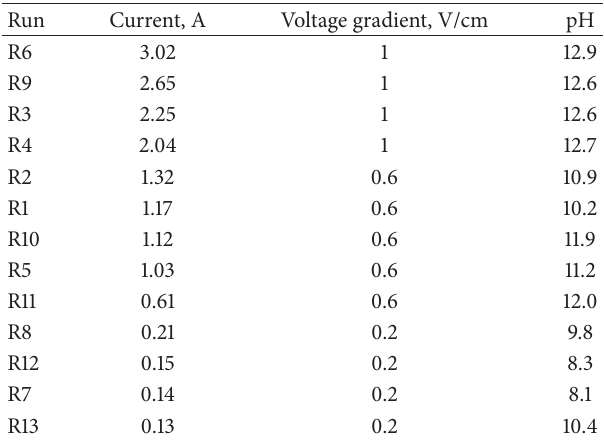
Table 5: Comparing electrical current with voltage gradient and soil pH for all tests.